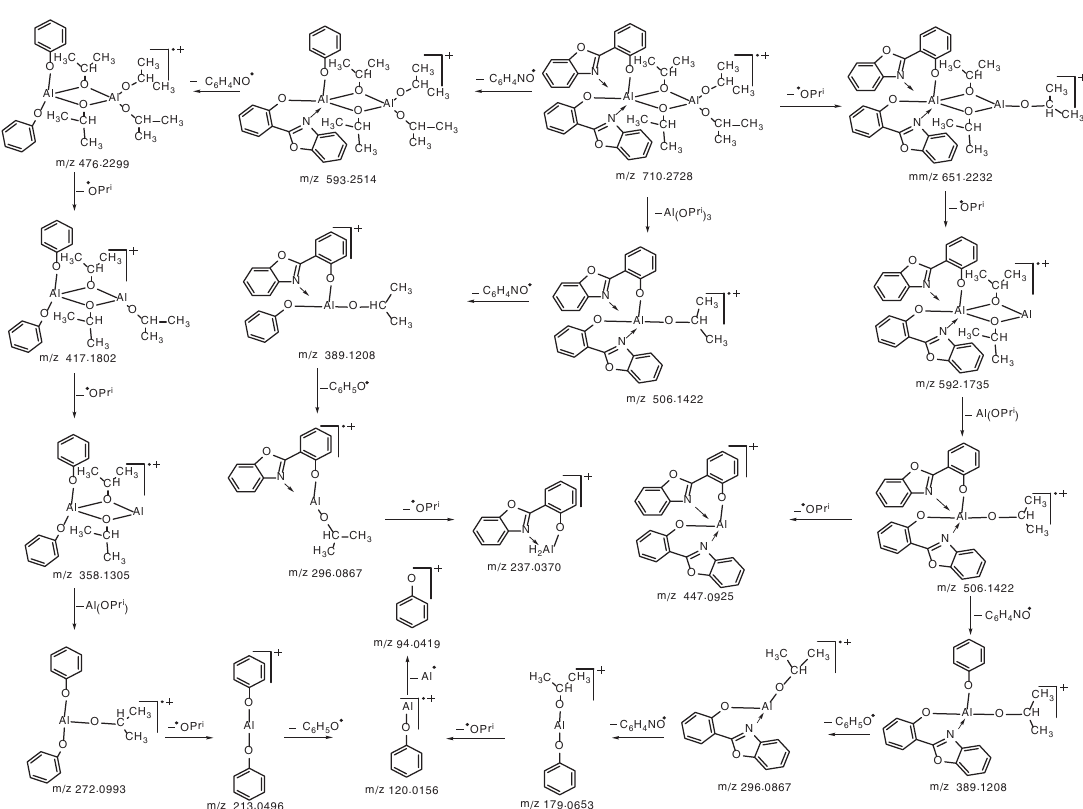
Al (spca) (OPr i 2 2 2